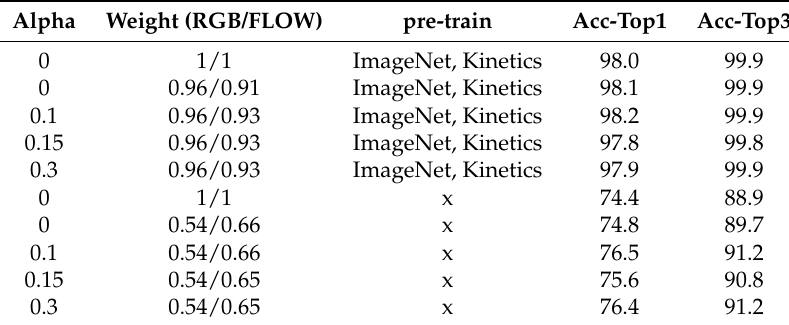
Table 3. Experiment about Score Fusion on